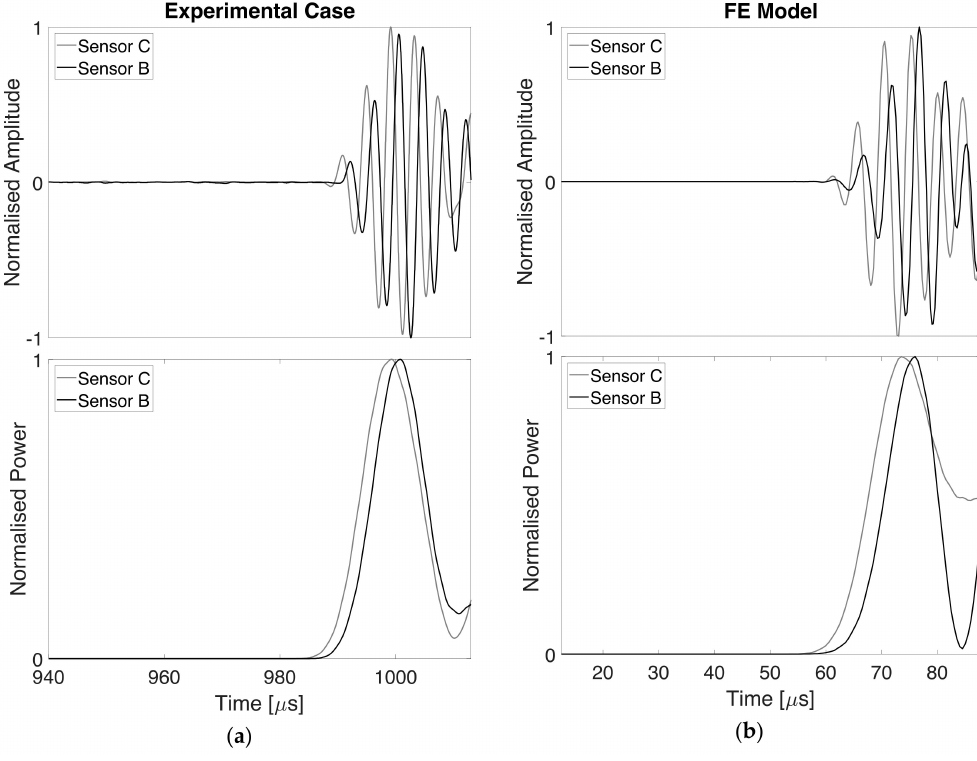
Figure 6. S 0 packet and Short Time Fourier Transform (STFT) at 200 kHz for ( a ) experimental results and ( b ) Finite Element Model (FEM) data. Table 2. First superharmonic amplitude for nonlinear